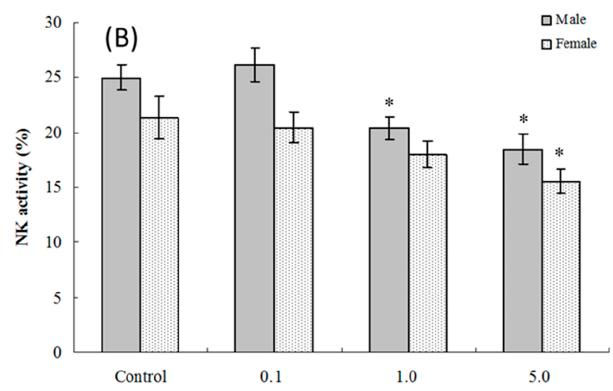
Figure 3. Splenic NK cell activity for cells from C57BL/6 mice exposed in utero to PFOS during GD 1–17. Cells obtained from mice at ( A ) four and ( B ) eight weeks of age. Data shown are the (mean ± SEM)% killing activity. * Value significantly different from respective controls ( p ≤ 0.05) by the one-way ANOVA test. n = 12 each group.